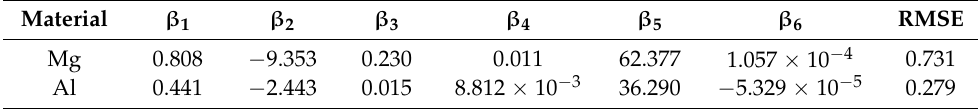
Figure 13. S L - x - t thickness calibration surface of Al and Mg. Table 7. Thickness calibration surface coefficients. Table 7. Thickness calibration surface coefficients.